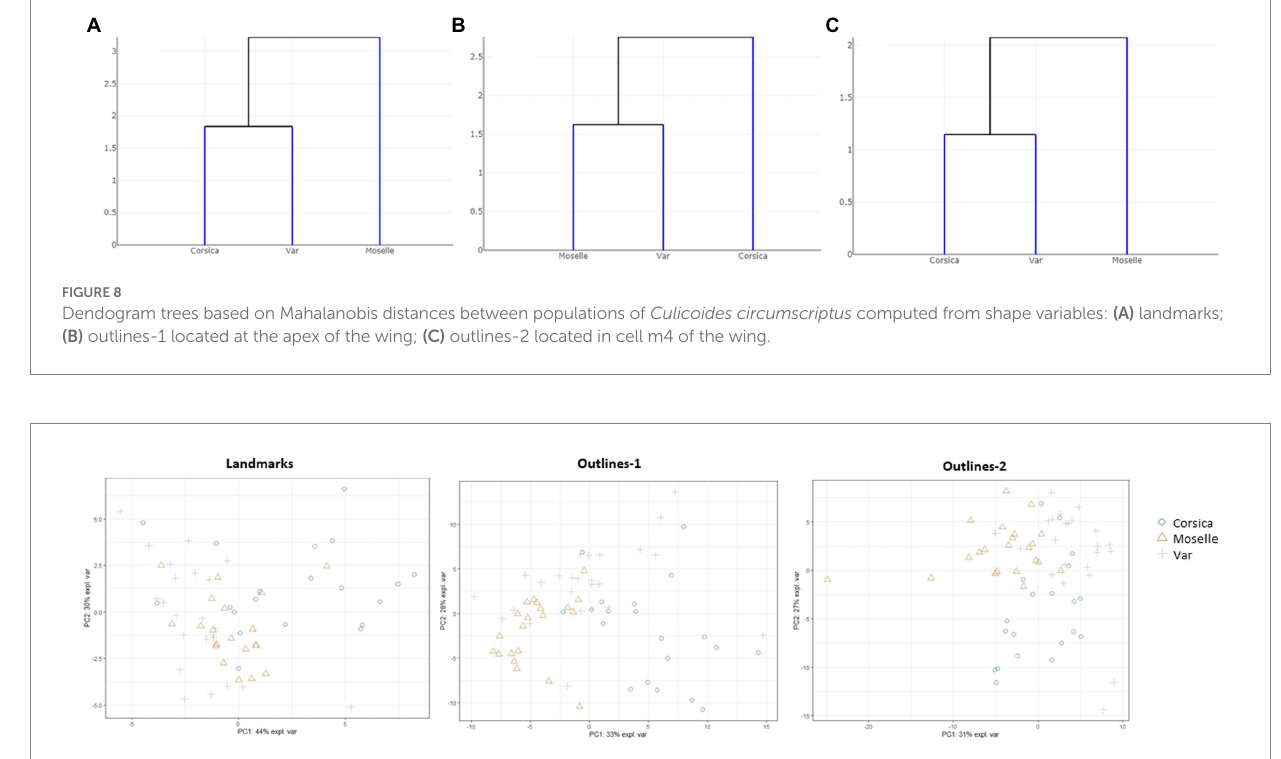
FIGURE 9 Principal component analysis (PCA) for each geometric morphometrics